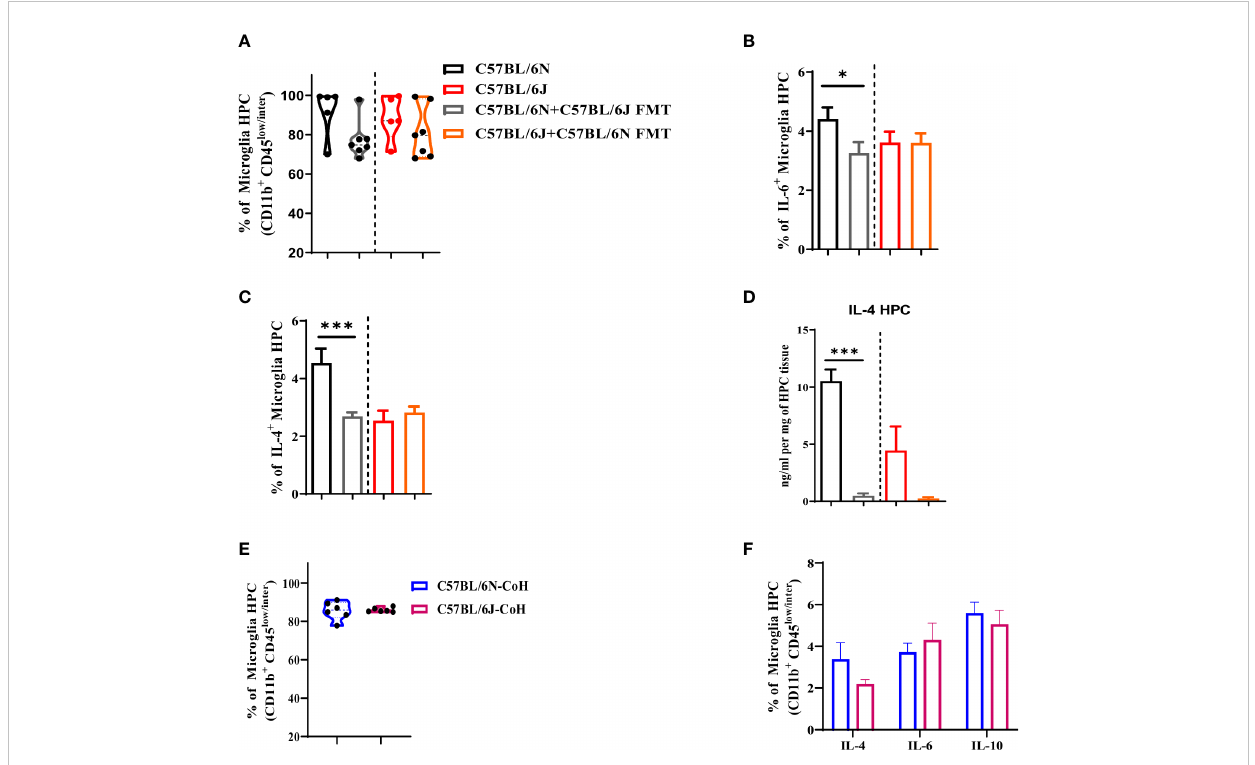
FIGURE 6 Microglia are responsive to microbial and environmental factors in C57BL/6 sub-strains. Hippocampus were collected from C57BL/6N and C57BL/6J under different experimental conditions to assess changes in microglia proportion and their cytokine production. (A) Frequency of microglia (CD11b + CD45 low/inter ). Frequency of microglia (CD11b + CD45 low/inter ) producing (B) IL-6 and (C) IL-4 upon FMT. (D) IL-4 level measured in HPC upon FMT using ELISA and normalized to mg of HPC tissue. (E) Frequency of microglia (CD11b + CD45 low/inter ) and (F) frequency of IL-4, IL-6, and IL-10- producing microglia in C57BL/6N and C57BL/6J after long-term co-housing. Results are representative of three independent experiments with 5 – 7 mice/group. Data are expressed as mean ± S.E.M. * P < 0.05, *** P < 0.0001 by two-tailed unpaired Student